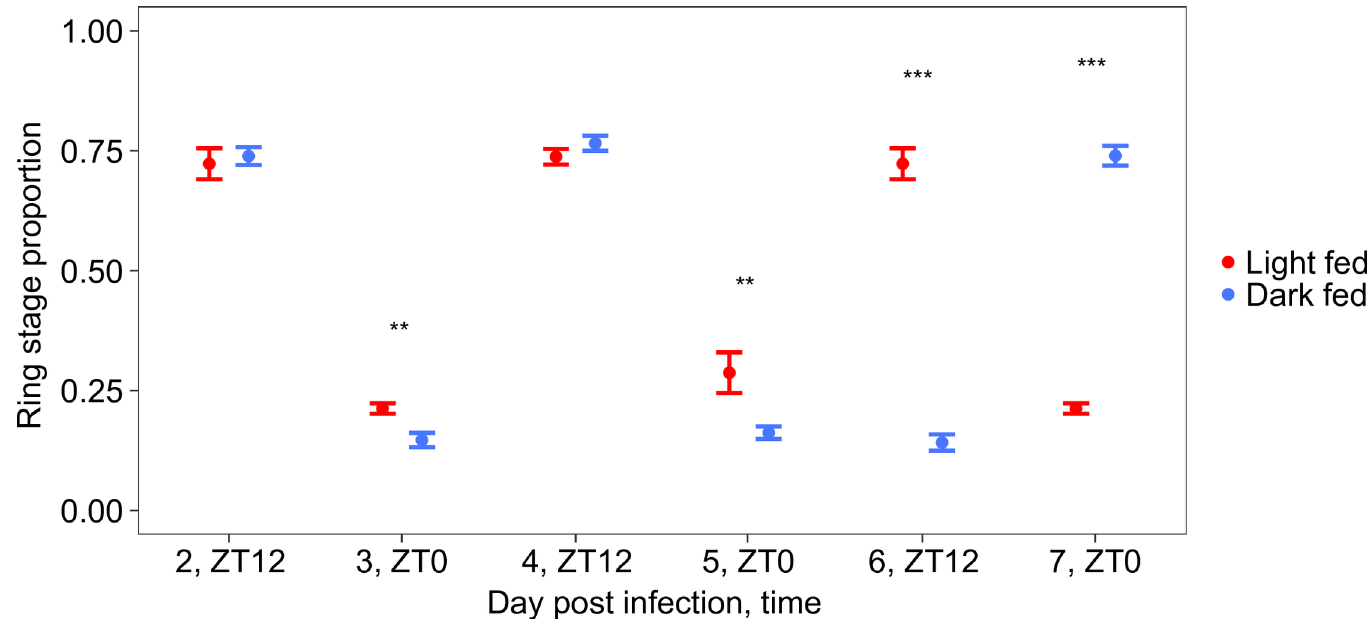
Fig 4. Parasite rhythms in light and dark fed mice significantly diverge by day 5–6 post infection. The proportion of ring stage parasites across infections (light fed mice, red, and dark fed mice, blue) as a phase marker reveals that rhythms of parasites in light fed mice (red) and dark fed mice (blue) diverge. Mice were sampled at ZT 12 on days 2, 4 and 6 and at ZT 0 on days 3, 5 and 7 post infection (see Fig 3 and S2 Fig). Consistent significant differences ( (cid:3)(cid:3) , p < 0.05; (cid:3)(cid:3)(cid:3) , p < 0.001) between feeding treatments begins on day 5. By days 6–7 post infection, rings in light fed mice are present at ZT12 while rings in dark fed mice are present at ZT 0, indicating that parasites in dark fed mice have rescheduled. Ring stages are presented as the phase marker because this is the most accurately quantified stage but other stages follow a similar pattern (S3 Table). Mean ± SEM is plotted and N = 10 for each treatment group.